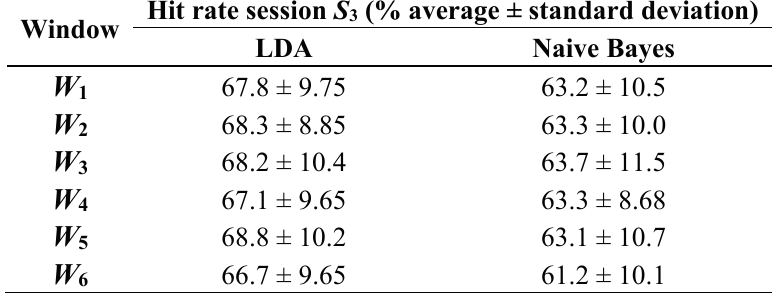
Table 4. Average hit rates using channels C3 and C4 for classification.